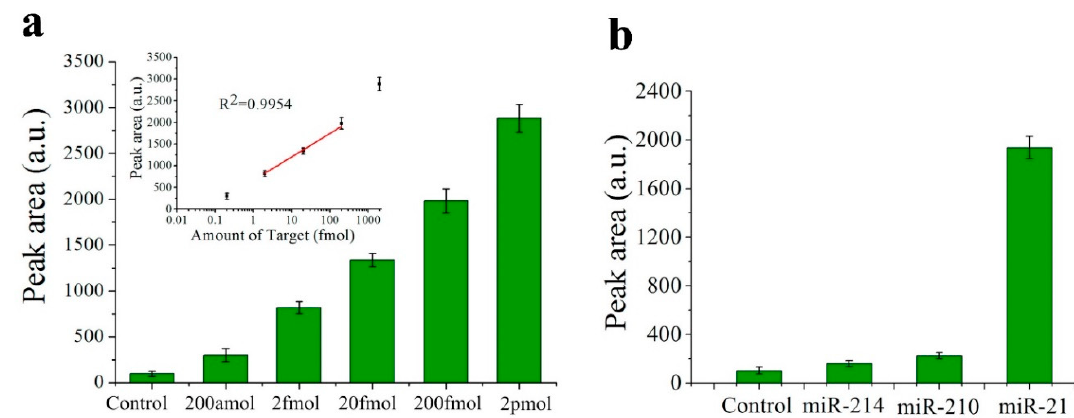
Figure 5. ( a ) Histograms of the peak areas on the test lines that correspond to a negative control and miR-21 in different concentrations. Inset shows the calibration plot of the peak area of the test line versus miR-21 concentration. ( b ) Histograms of the peak areas on the test lines in a specificity assay: negative control, miR-214, miR-210-3p (indicated as miR-210) and miR-21. ( a , b ). Reprinted [49], Copyright 2017, with permission from Elsevier.